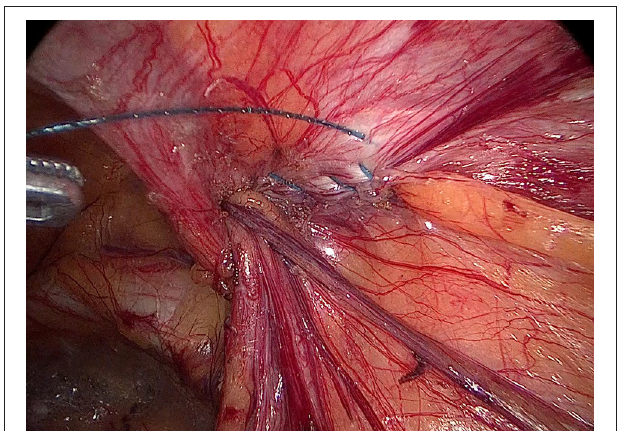
FIGURE 6 | The closed internal